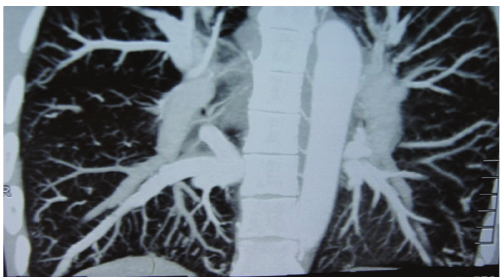
Figure 3: Contrast echocardiography shows that microbubbles ( the arrow) produced by contrast agent enter the left ventricle three heart beats after the right.